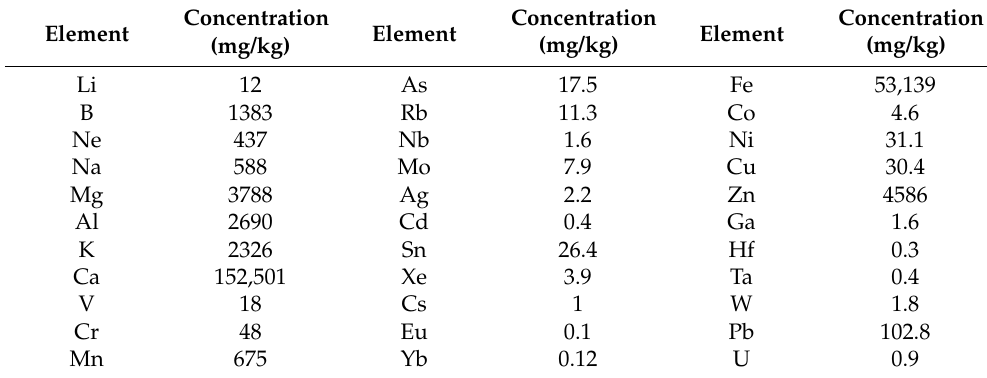
Table 1. Chemical composition of the CS-30 cyclotron’s concrete wall.